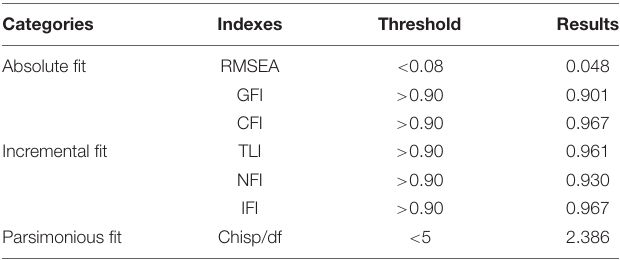
TABLE 5 | The goodness of fit indexes measurement.